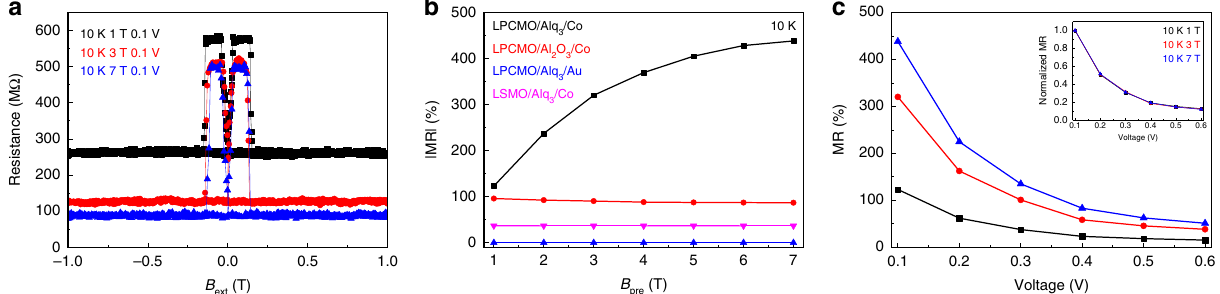
Fig. 2 EPS-modulated MR response in the LPCMO-OSV device. a MR ( B ext ) loops of the LPCMO-OSV device under three pre-set magnetic fi eld strength (i.e., 1 T, 3 T, and 7 T). MR measurements were taken at T = 10 K by applying a voltage bias V = 0.1 V. b The obtained j MR j values from the LPCMO/Alq 3 / Co, LPCMO/Al 2 O 3 /Co, LPCMO/Alq 3 /Au, and LSMO/Alq 3 /Co devices as a function of pre-set magnetic fi eld ( B pre ). c Bias dependence of MR values in the LPCMO-OSV device under the pre-set magnetic fi eld of 1 T, 3 T, and 7 T, respectively. The inset shows the normalized MR vs. V curves in panel